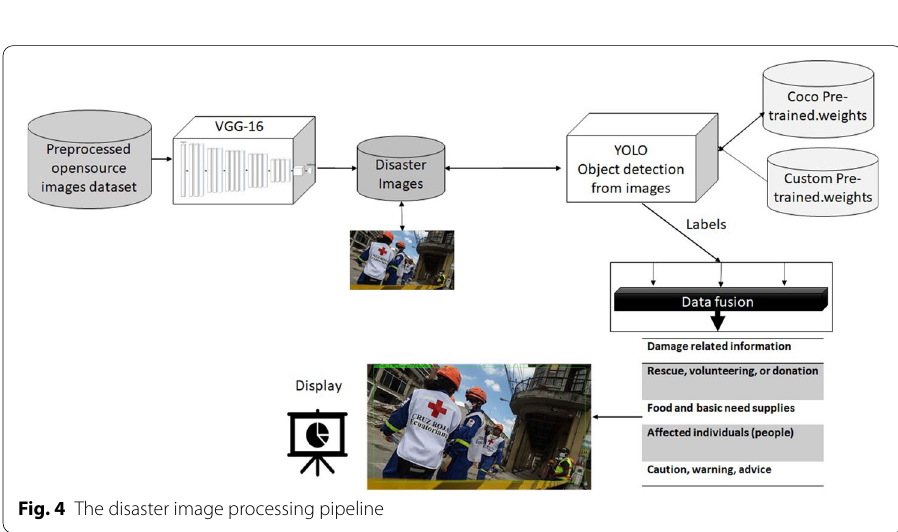
Fig. 4 The disaster image processing